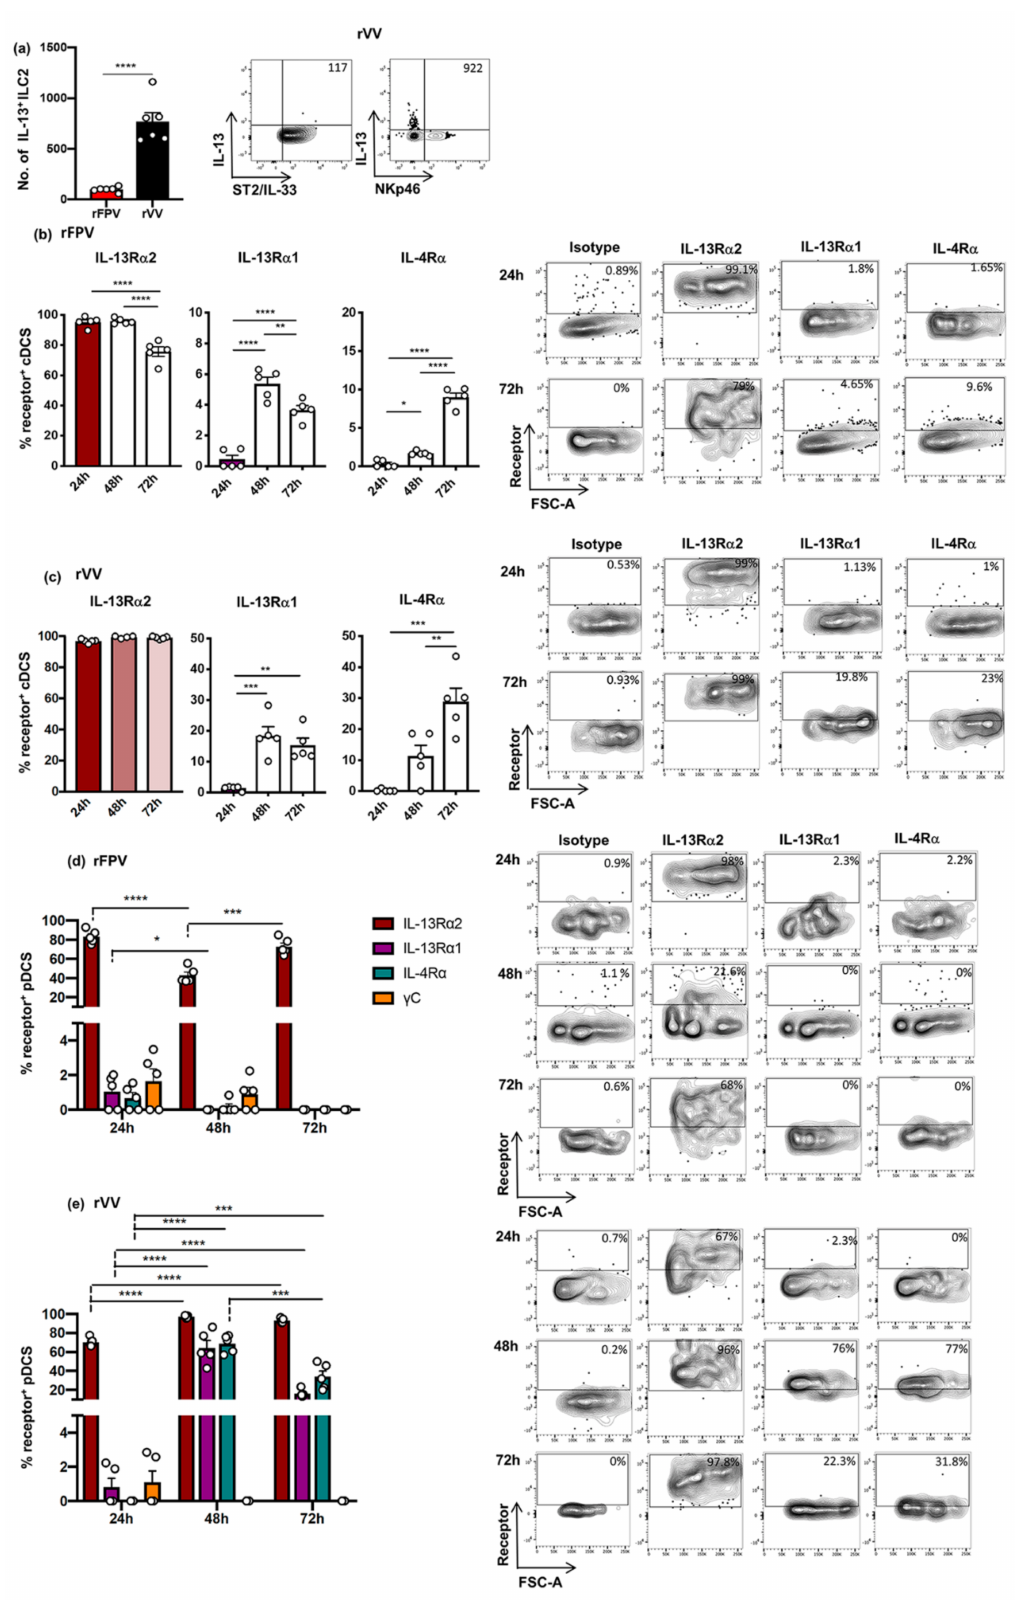
Figure 7. Evaluation of lung ILC2-derived IL-13 expression and lung cDCs and pDCs expressing IL-4/IL-13 receptors, following intranasal rFPV and rVV vaccination. BALB/c mice (n = 6 per group) were immunized i.n. with FPV-HIV or VV-HIV, 24 h post vaccination single cell suspensions from lungs were prepared and stained for lineage − ST2/IL-33R +